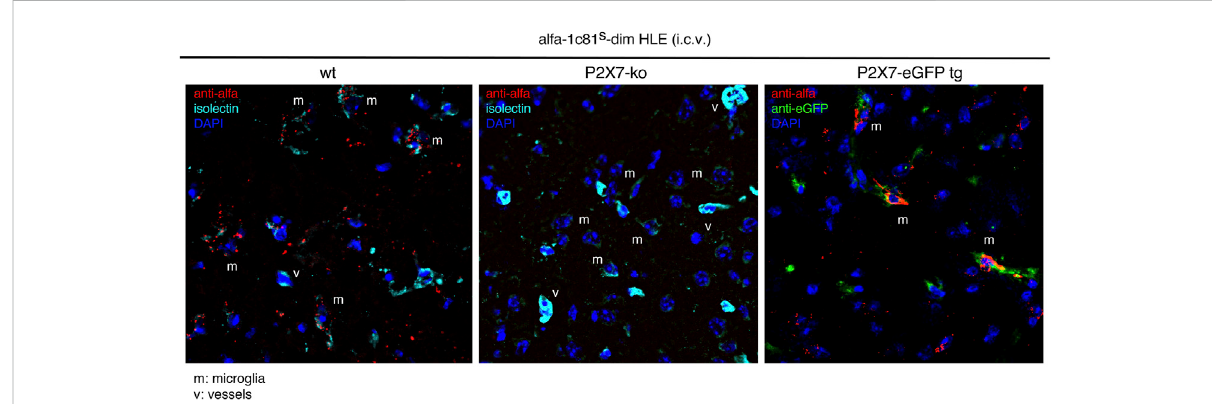
FIGURE 5 Detection of P2X7 nanobodies bound to the cell surface of microglia on brain sections. Target binding of 1c81 s -dim HLE nanobody on brain cryosections was determined 24 h following i. c.v. injection of a low dose of 0.5 mg/kg in wildtype mice. P2X7-de fi cient mouse and a P2X7-eGFP transgenic mouse expressing high levels of P2X7-eGFP fusion protein were used as controls. For this experiment an ALFA-tagged version of 1c81 s -dim HLE nanobody has been used, allowing detection on brain sectionswith an ALFA-speci fi cnanobody (red). Microglia are stained with isolectin (cyan) and P2X7-eGFP with an eGFP-speci fi c mouse monoclonal antibody (mAb) (green). (v) point to blood vessels brightly stained with isolectin and (m) shows microglial cells weakly stained with isolectin. Data are representative of two independent experiments. Dot plots shown are from a single mouse. An independent experiment refers to an experiment with a single mouse per condition, in which all mice were analyzed on the same